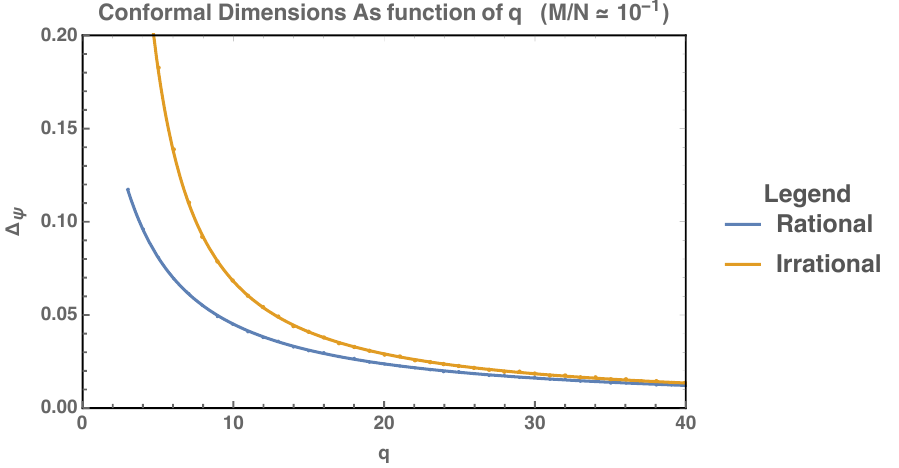
Figure 4. This plot shows the conformal dimension (cid:1) for both the irrational and the rational case as a function of q . The points indicate the numerical values, whilst the lines are the (cid:12)ts found in eq. (4.7). We only show a small amount of these points such that the (cid:12)ts can be clearly distinguished. As can be seen, the power series up to 1 =q 4 describes the results with high